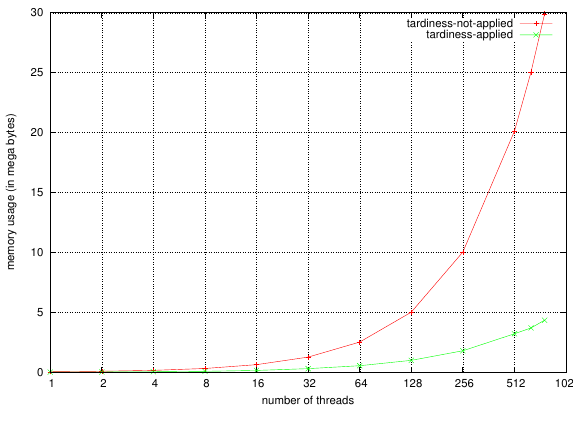
Fig. 8: Memory usage (megabytes). geometry and the evolution of the shock-wave propagation effect in time. The wave propagation starts in (A) and ends in (D). The buildings interfere in the wave propagation. Parts (A) and (B) omit buildings to help in visualizing wave reflection. Parts (C) and (D) present the complete scene.